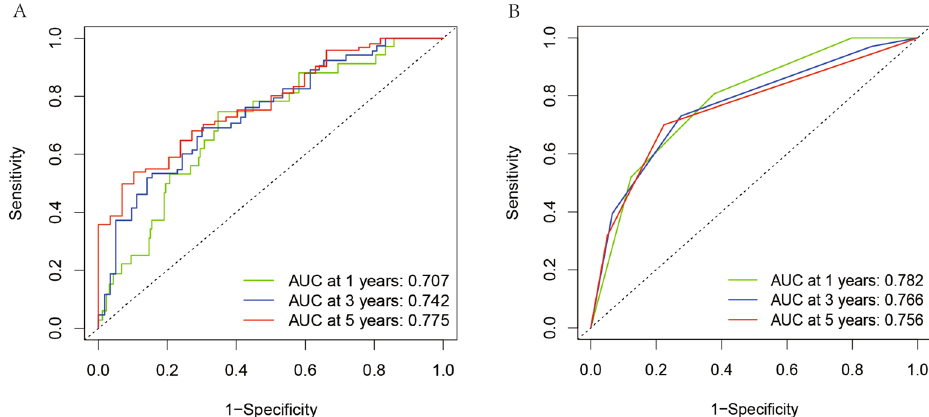
Figure 7. The comparison of this model with TNM stage by the time-dependent ROC curve and AUC of 1, 3, and 5-year. ( A ) For our predict model, the AUC was 0.707 (1-year), 0.742 (3-year) and 0.775 (5-year), respectively. ( B ) For TMN stage, the AUC was 0.782 (1-year), 0.766 (3-year) and 0.758 (5-year), respectively.